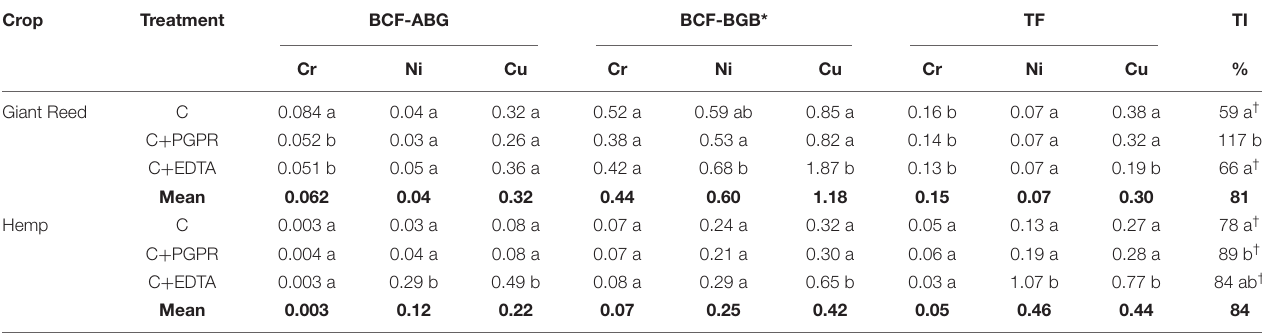
TABLE 3 | Bioconcentration (BCF) and translocation (TF) factors and tolerance index (TI) for hemp and giant reed. Crop Treatment BCF-ABG BCF-BGB*